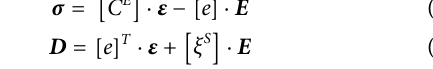
The linear constitutive relations that de fi ne the coupling between mechanical stress, mechanical strain, electric fi eld, and electric displacement are given as (Rupitsch, 2019): where σ is stress tensor, D is electric displacement vector, ε is strain tensor, E is electric fi eld, [ C E ] is elastic constant at constant of e , and [ ξ S ] is dielectric tensor at constant mechanic strain. The